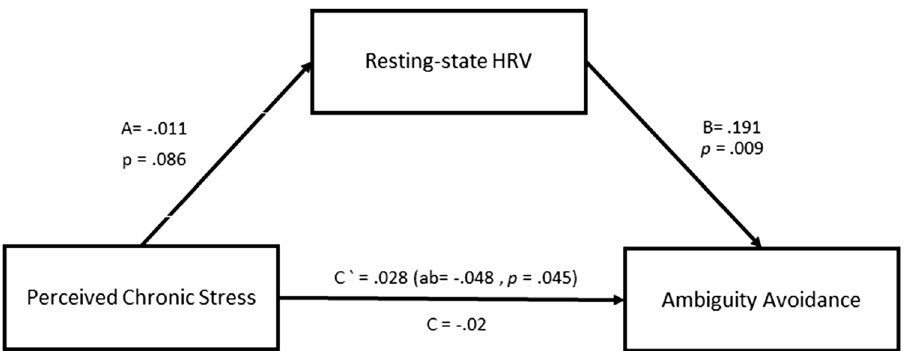
Figure 4. Mediation model. Resting-state HRV fully mediates the association between perceived chronic stress and ambiguity avoidance. ( C ) represents the standardized total direct effect, ( C’ ) represents the standardized direct none-mediated effect in the presence of the mediator (HRV) and ( A and B ) represent the standardized indirect (mediated)